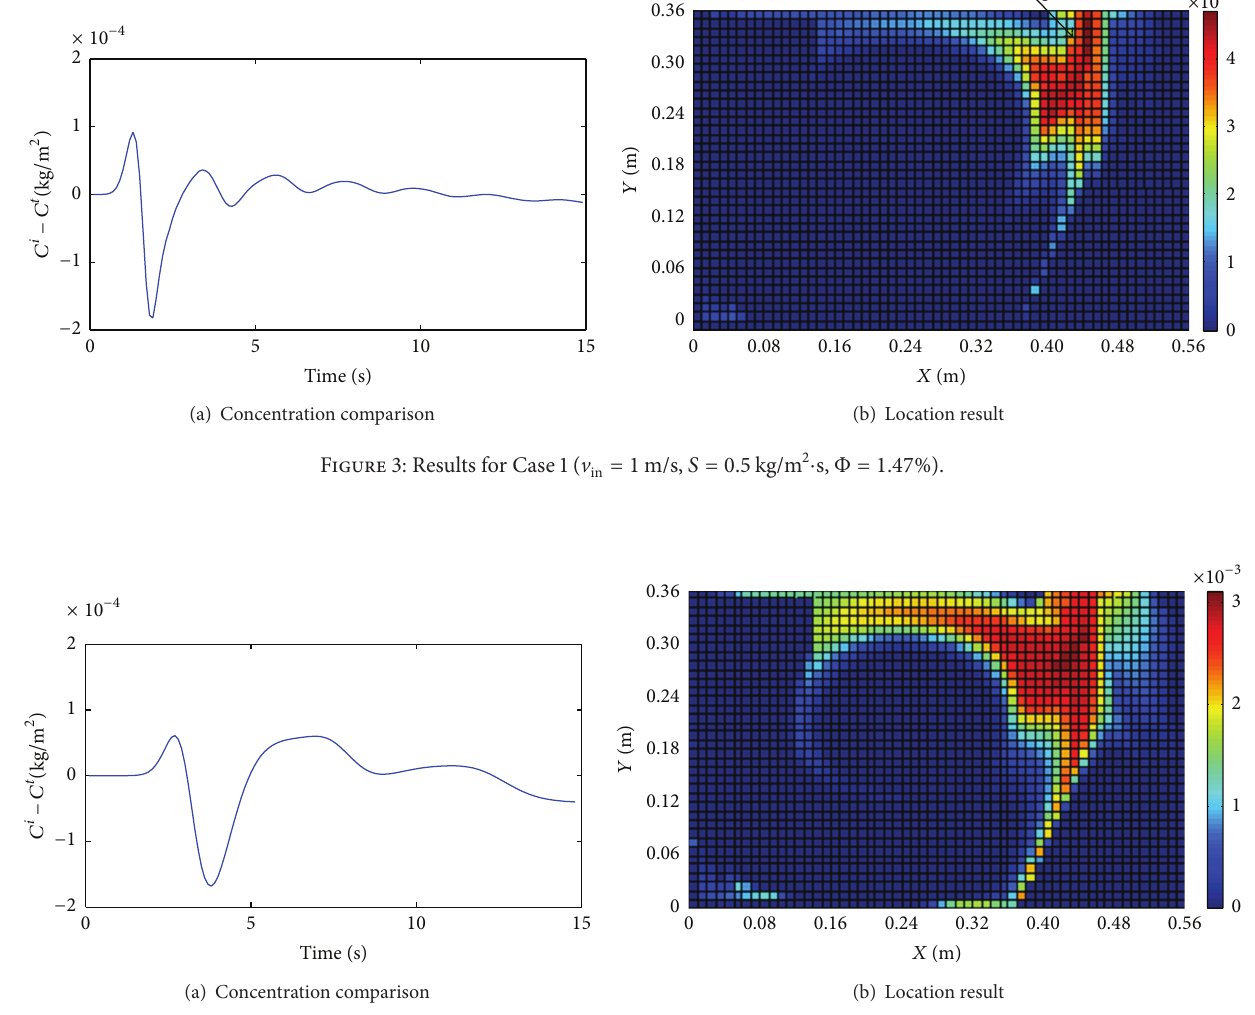
= 0.5 m/s, 𝑆 = 0.5 kg/m 2 ⋅ s, and Φ = 10.43 %). in